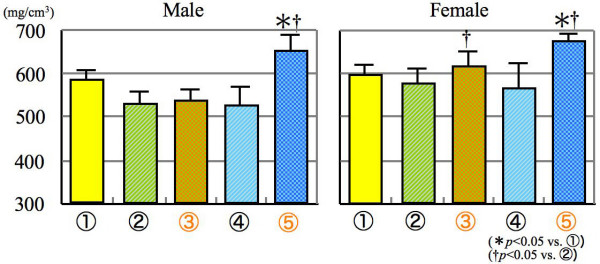
Total bone density.